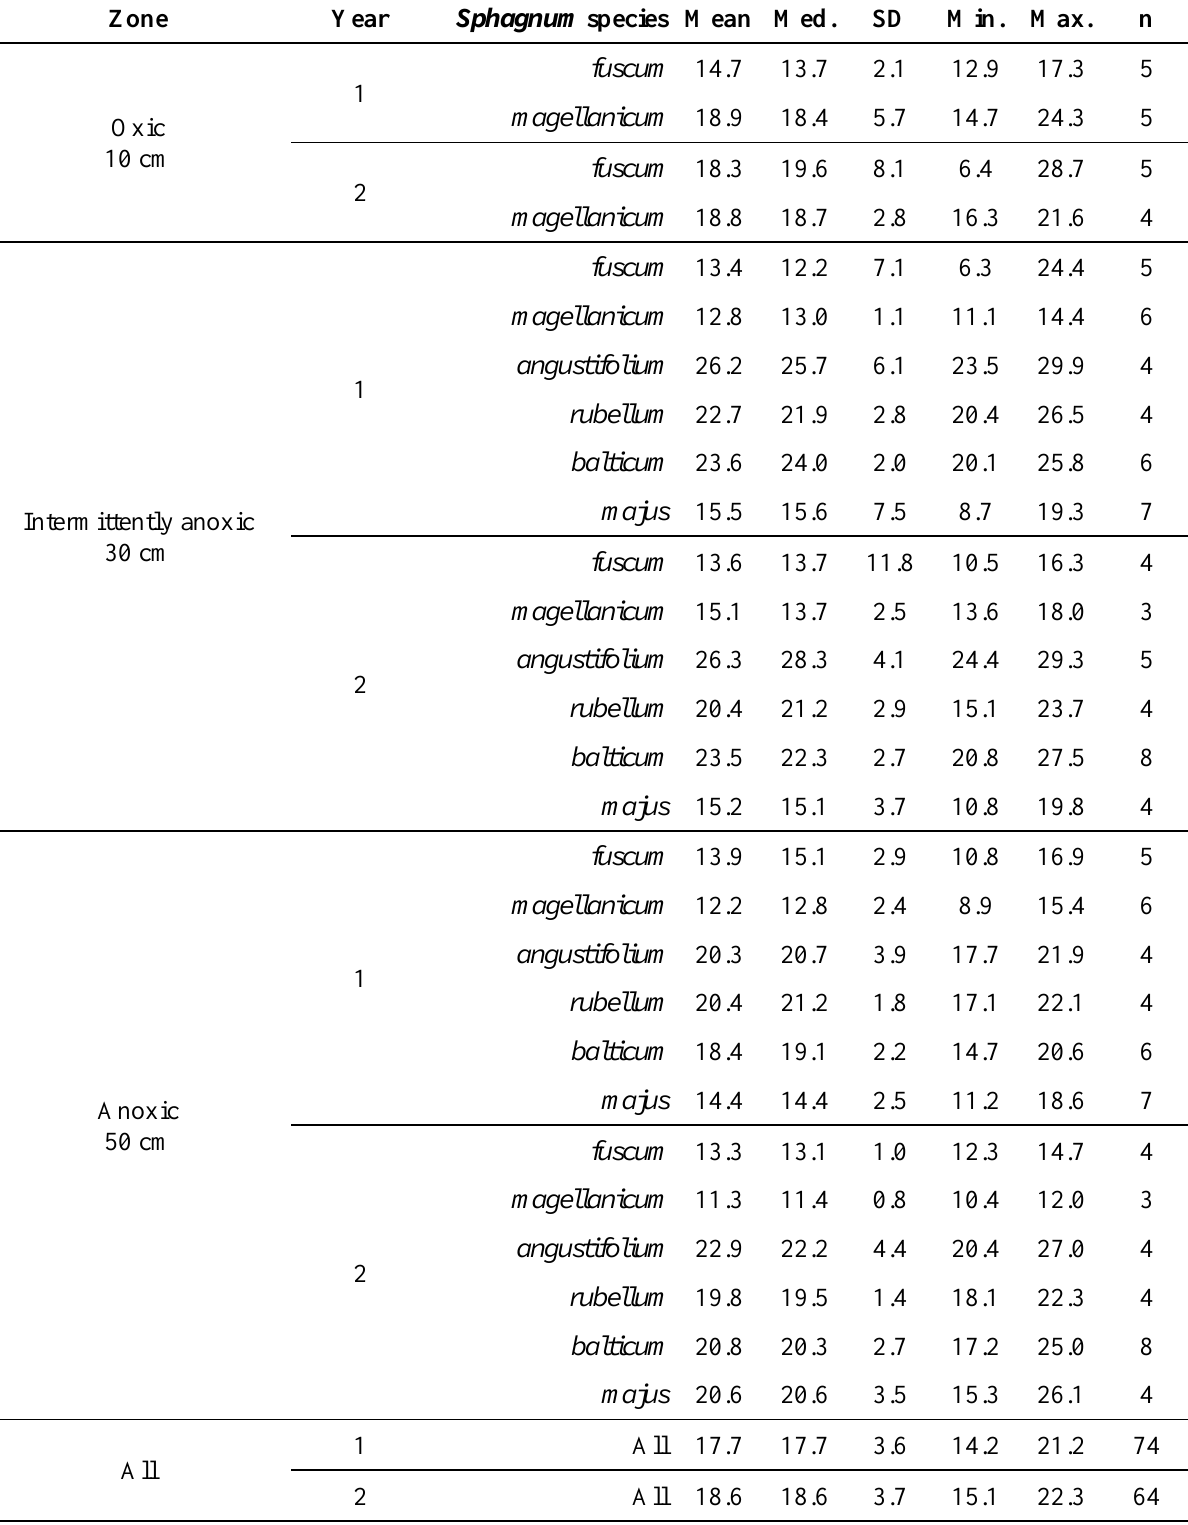
Table 1. Mean, median (Med.), standard deviation (SD), minimum (Min.) and maximum (Max.) (n = 3–8) mass remaining as a percentage of the original mass after one and two years for: S. fuscum and S. magellanicum at depths of 10, 30 and 50 cm below the mire surface in hummocks; S. angustifolium, S. rubellum and S. balticum at depths of 10 and 30 cm below the surface in lawns; and S. majus at depths of 10 and 30 cm below the surface in